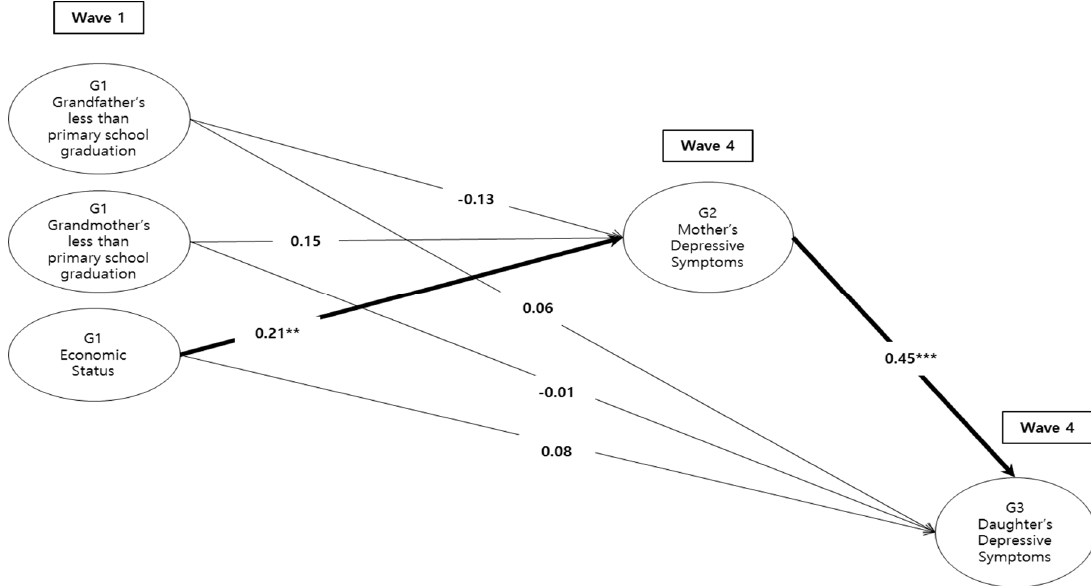
Figure 2. Standardized results of the intergenerational model by the mother’s depressive symptoms (G2) as a mediator. The model above controls mother’s and daughter’s demographic factors such as mother’s age, mother’s living with spouse, mother’s number of siblings, mother’s family income, and mother’s employment, daughter’s age, daughter’s year of education, daughter’s number of siblings, and daughter’s employment. The thick line in the figure indicates statistical significance. ** p < 0.01, *** p < 0.001.